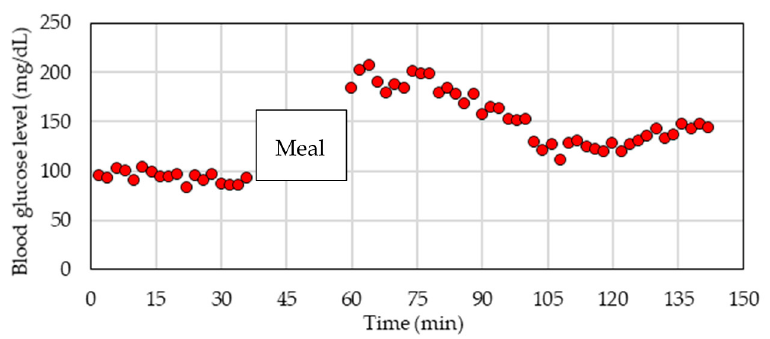
Figure 2. The time-series change in the blood glucose level (subject D).